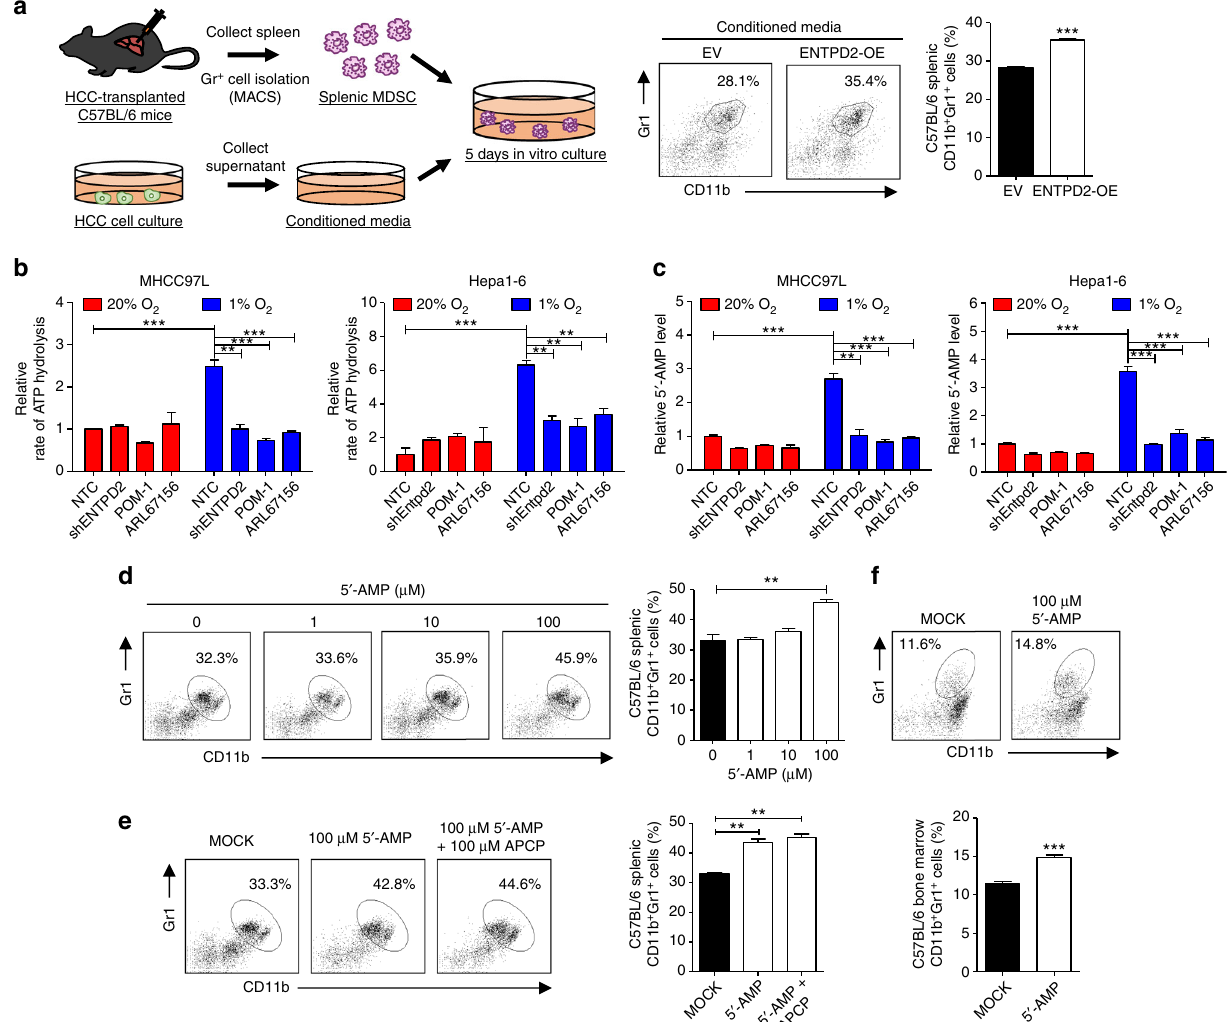
Fig. 4 ENTPD2 hydrolyzes ATP to 5 ′ -AMP that contributes to MDSC maintenance. a The effect of ENTPD2 on MDSC maintenance. Splenic MDSCs isolated from C57BL/6 mice were cultured in conditioned media collected from MHCC97L-EV and -ENTPD2-overexpressing (OE) clones. The percentages of CD11b + Gr1 + cells after 4-day culturing were analyzed ( n = 3). b Liquid chromatography-mass spectrometry (LC-MS) analysis of the rate of